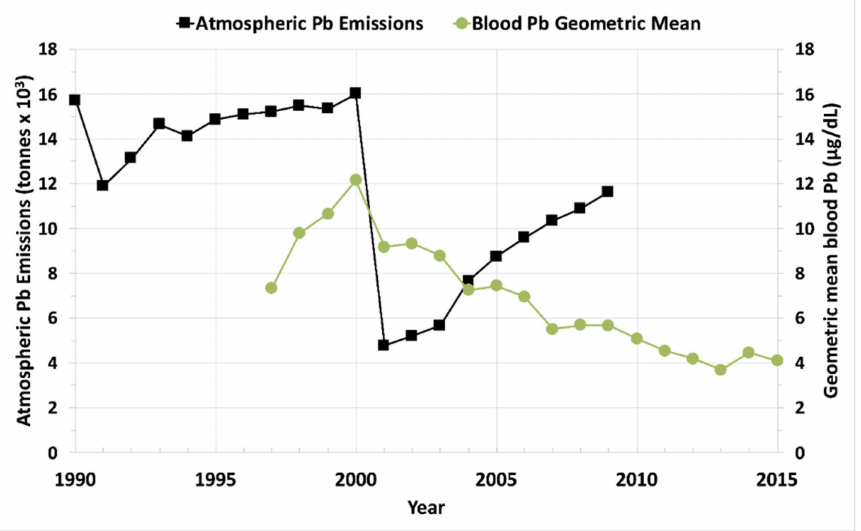
Figure 3. Based on the raw data provided in atmospheric Pb and blood Pb in urban and rural communities appear to be out of sync. The main interest is 2000 when China banned leaded petrol. Air Pb dropped precipitously followed by a sharp, although not as steep, decline in blood Pb, a subsequent more gradual decrease, and a flattened response after 2014.